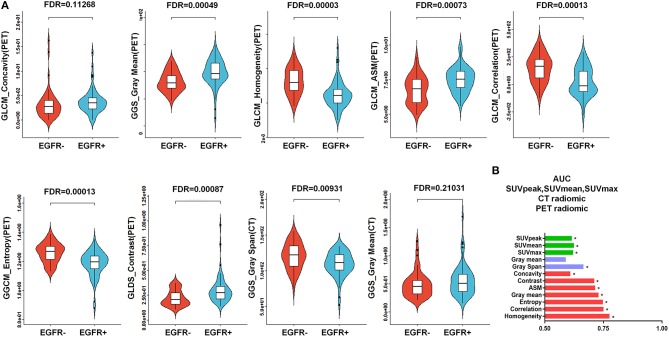
Predictive power of the PET/CT-derived radiomic signature for EGFR mutational status. (A) Box plots for all 7 of the identified PET-derived radiomic features and the 2 CT-based radiomic features between the mutant-type of EGFR and wild-type of EGFRsubgroups. Except for a CT-derived radiomic feature called gray mean, all of the identified radiomic features were significantly different between the mutant-type of EGFR and wild-type of EGFR subgroups. (B) Evaluation of the predictive value of individual identified radiomic features for EGFR mutational status by receiver operating characteristic (ROC) analysis. *indicates that the value of the area under the curve (AUC) was significantly greater than a random guess (AUC = 0.5). As presented, all of the identified individual radiomic features were capable of discriminating EGFR mutated cases from cases without EGFR mutation, except for a CT-based radiomic feature called gray mean. In general, the PET-derived individual radiomic feature outperformed the conventional PET parameters in distinguishing the mutant-type of EGFR and wild-type of EGFR subgroups. EGFR, epidermal growth factor receptor; PET, positron emission tomography; CT, computed tomography; EGFR+, mutant-type of EGFR; EGFR-, wild-type of EGFR.